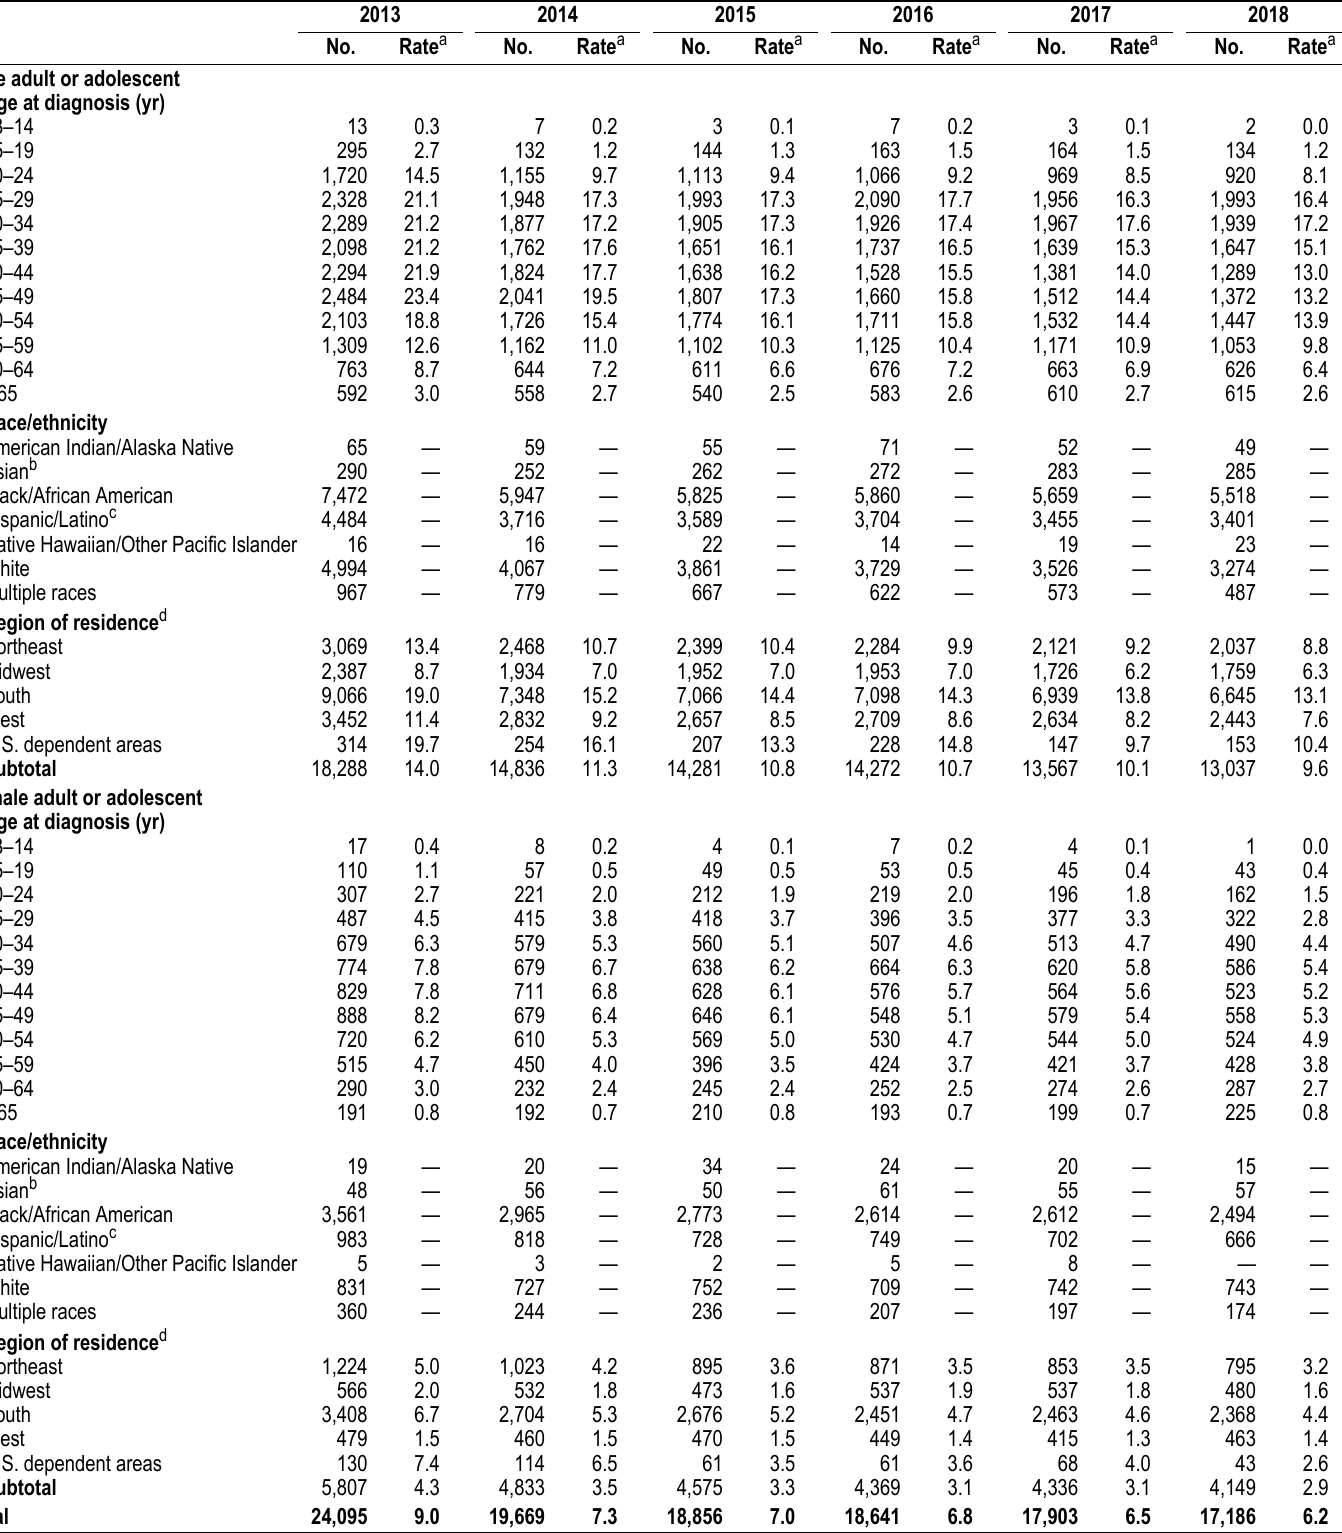
Table 6b. Stage 3 (AIDS) among adults and adolescents, by year of diagnosis, sex, and selected characteristics, 2013–2018—United States and 6 dependent